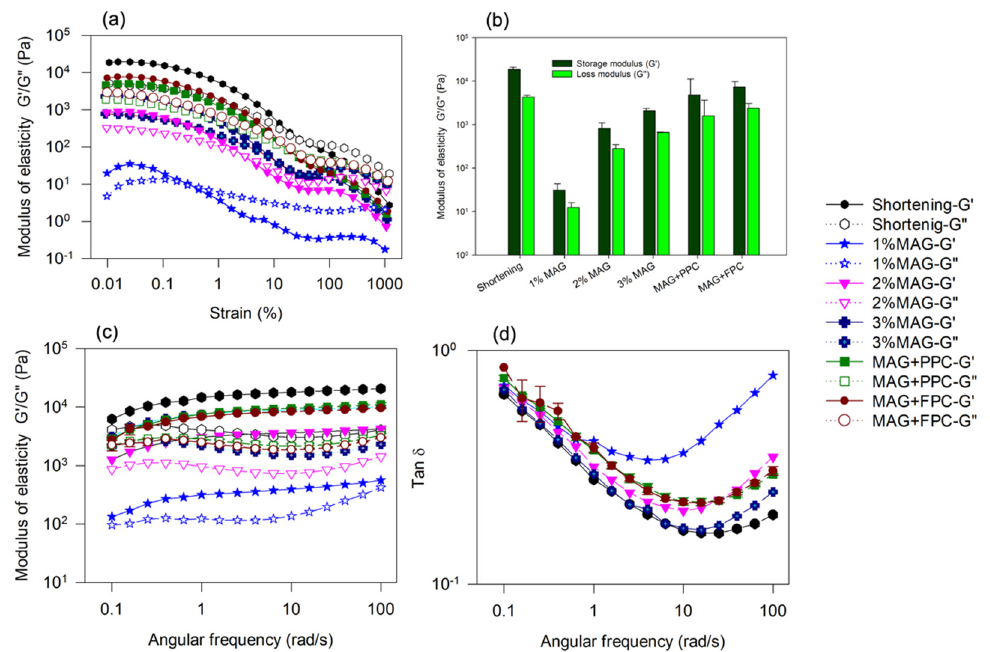
Figure 2. ( a ) Viscoelastic modulus of oleofoams measured as a function of oscillation strain% at a constant frequency of 0.5 Hz at room temperature. ( b ) Comparison of storage (G ′ ) and loss moduli (G ′ ) of the oleofoams at 0.05% strain. ( c ) Viscoelastic moduli and ( d ) tan δ of oleofoams as a function of angular frequency at a constant oscillation strain of 0.05%. MAG, monoacylglycerols; PPC, pea protein concentrate-stabilized foam; FPC, faba bean protein concentrate-stabilized foam.